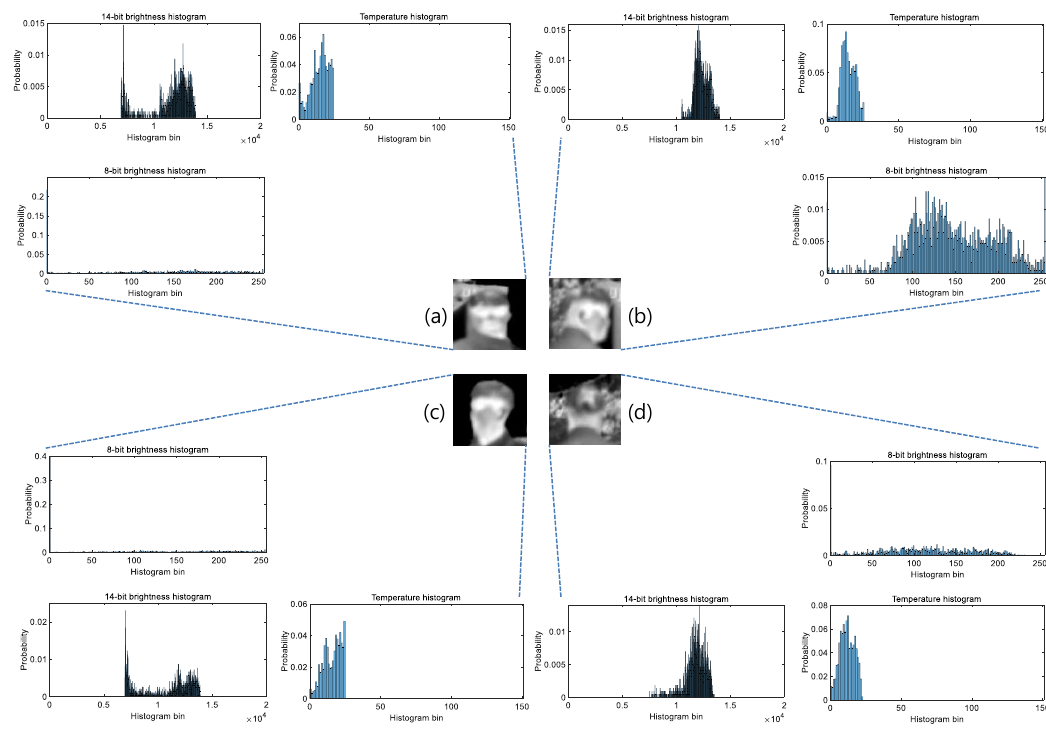
Figure 9. Comparison of the brightness histogram and temperature